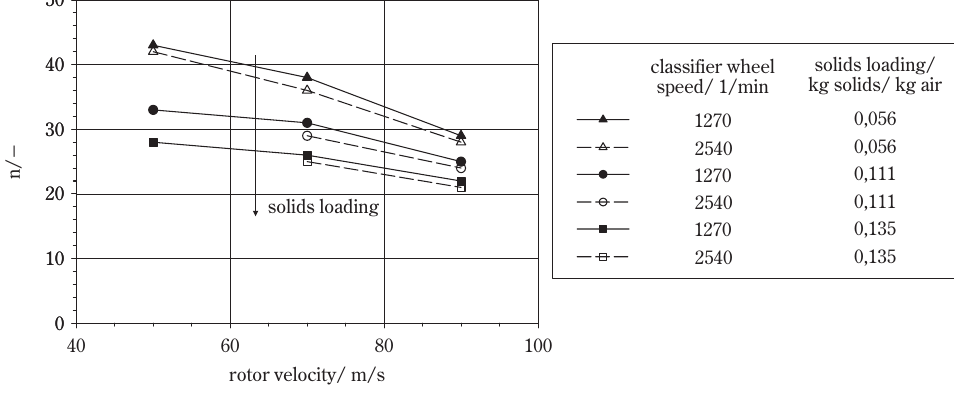
classifier wheel speed/ 1/min